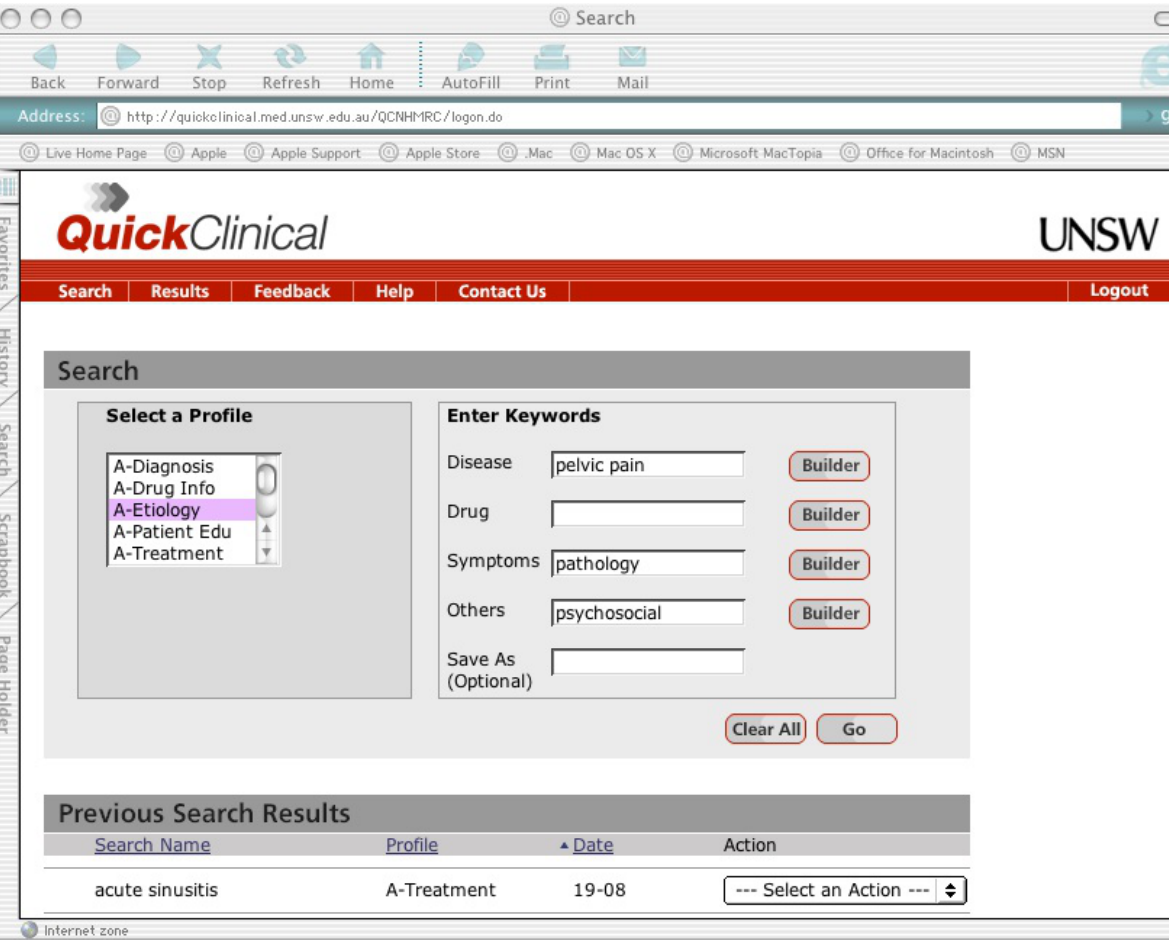
Figure 1. User interface of